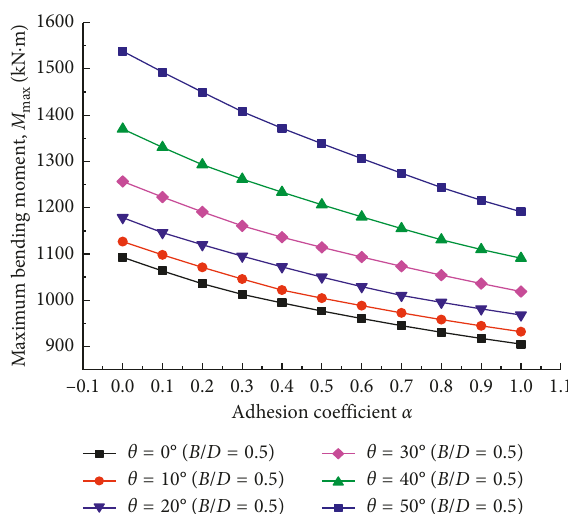
Figure 23: Pile head deflection ( y max ) variation with 0 ) variation with undrained shear strength ( c u ) for different slope angle.